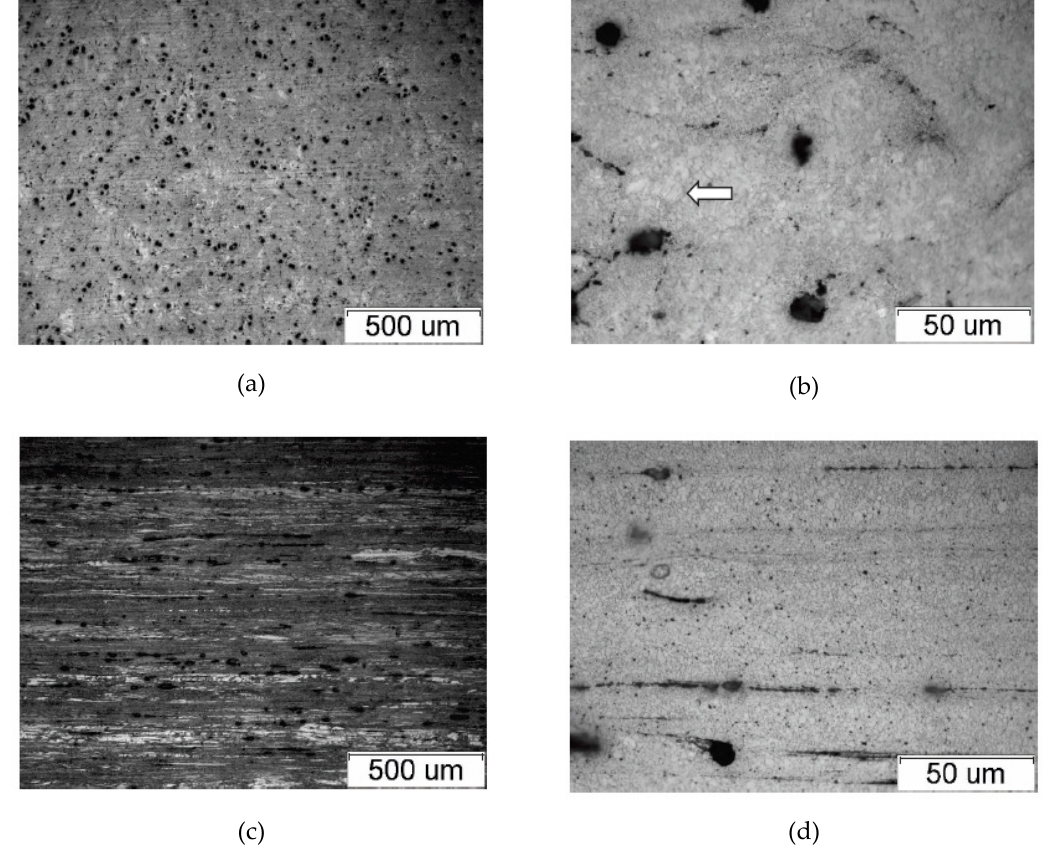
Figure 4. OM micrographs of KoBo-extruded Mg-Csf composite sections: ( a , b ) transverse and ( c , d ) longitudinal, white arrow indicates non-recrystallized primary grains.